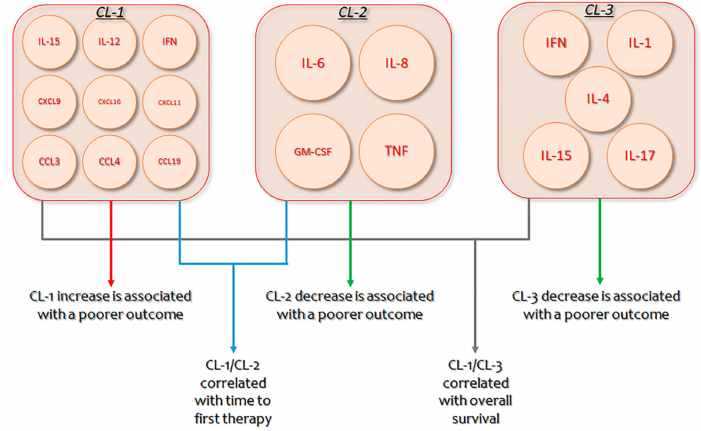
Figure 2. Clusters of identified cytokines, their respective interplay, and their impact on Chronic lymphocytic leukemia (CLL) prognosis. CL: Cluster; IFN: interferon; GM-CSF: Granulocyte-Macrophage Colony-Stimulating